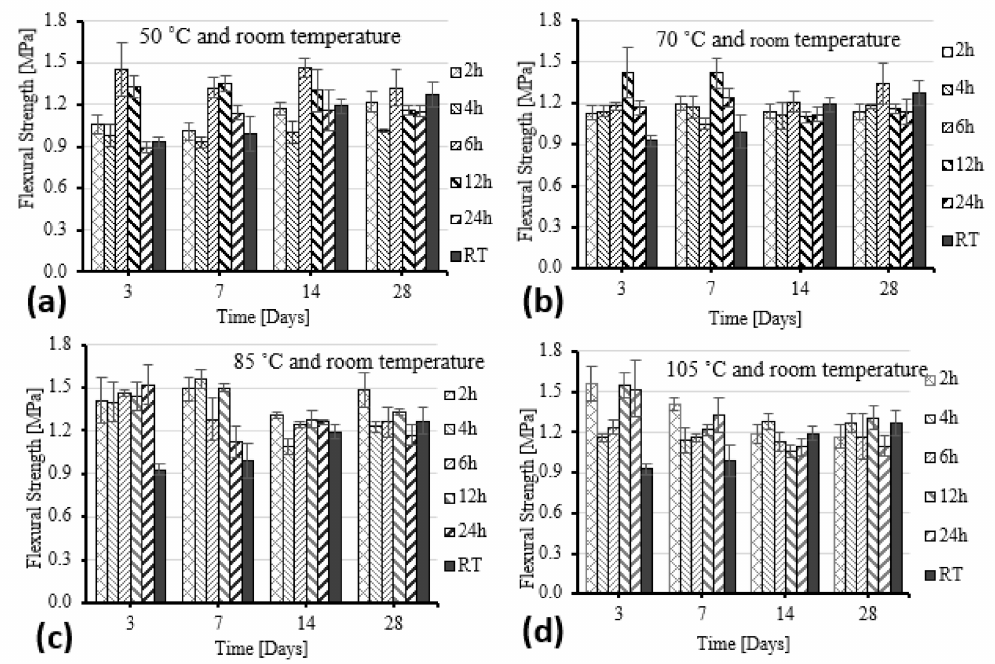
Figure 2. Flexural strengths of geopolymer foam (GF) at different curing temperatures: ( a ) 50 ◦ C, ( b ) 70 ◦ C, ( c ) 85 ◦ C and ( d ) 105 ◦